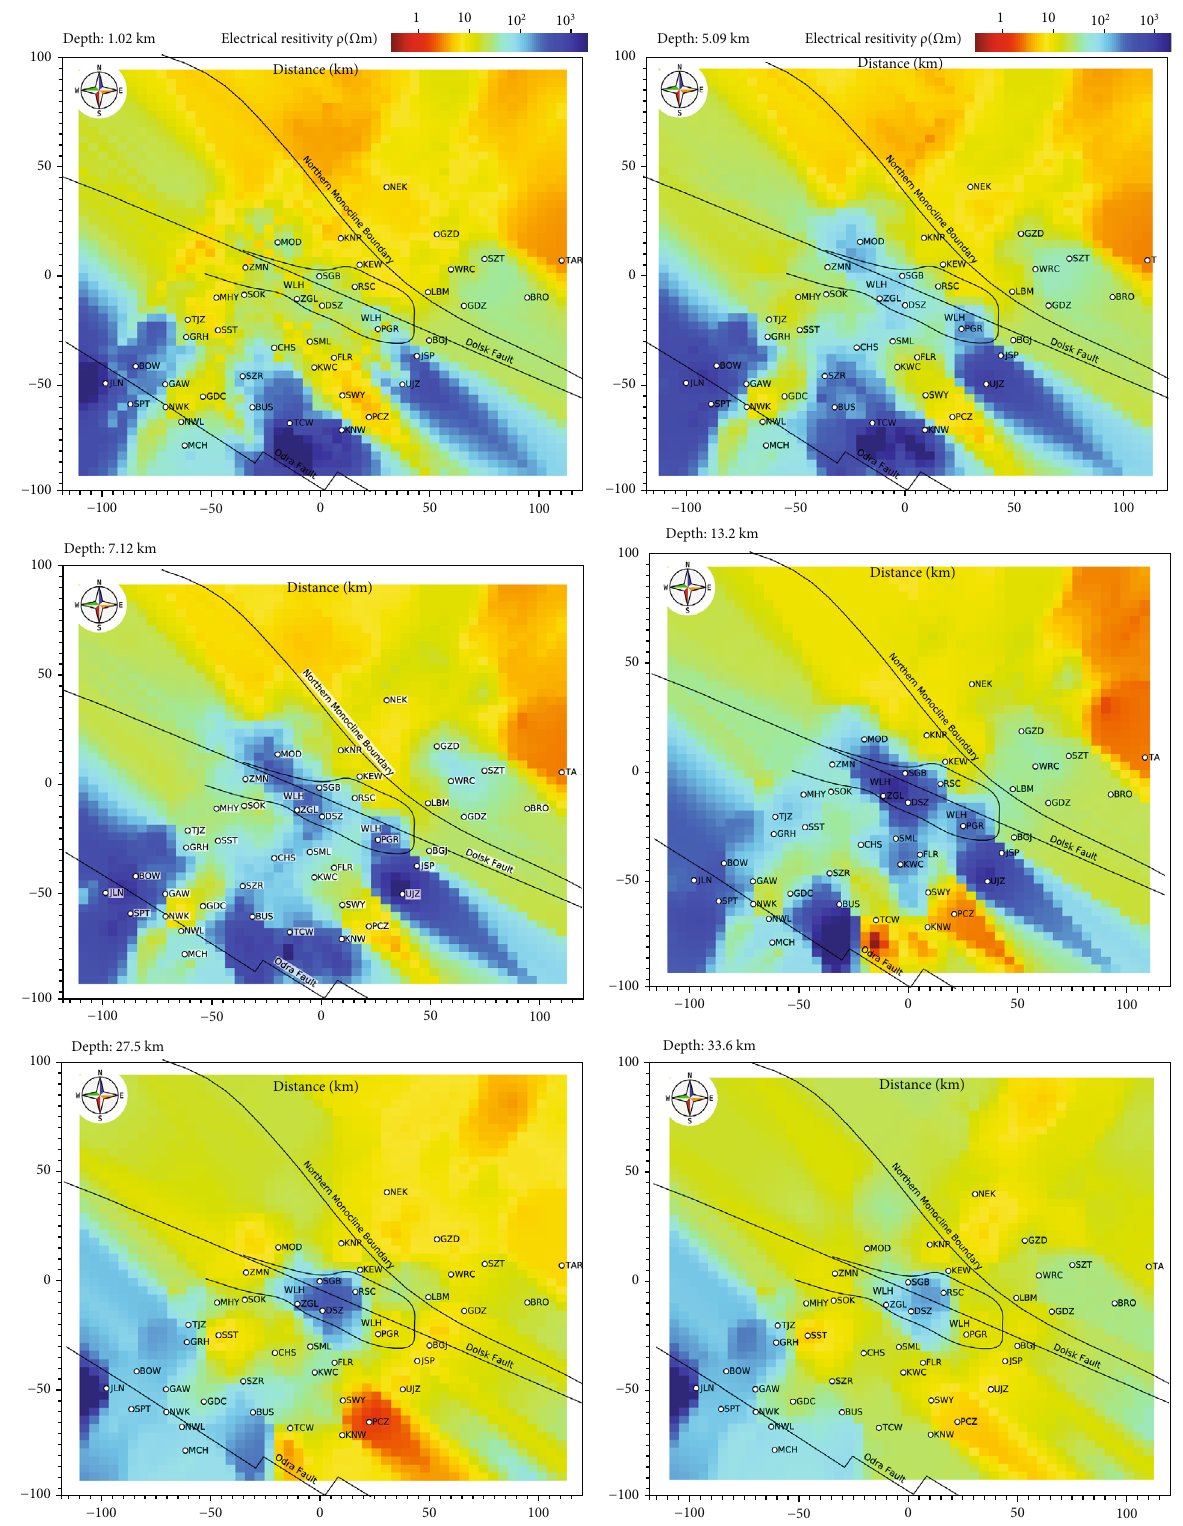
Figure 13: Presentation of 1D Occam inversion results in depths ranging from 0 to 50 as depth sections for depths of 1.02, 5.09, 7.12, 13.2, 27.5, and